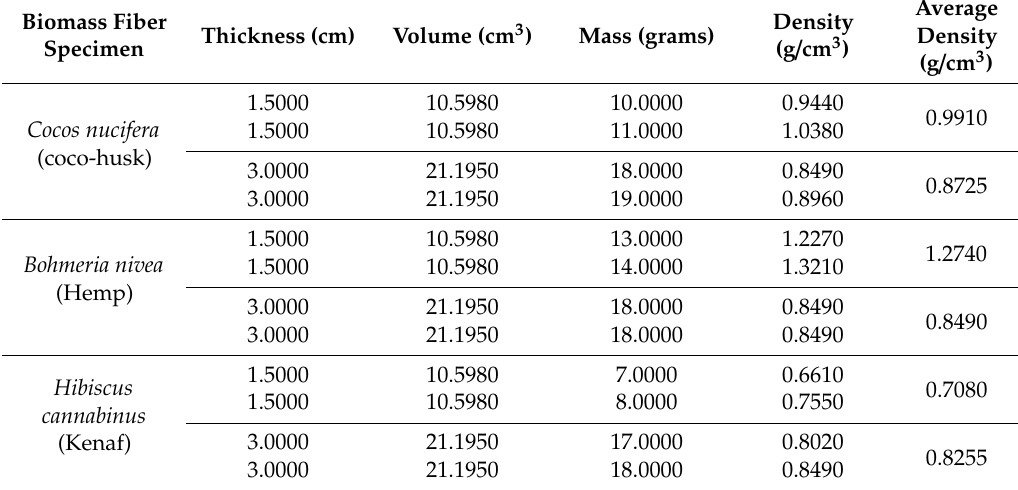
Table 2. The epoxy resin-reinforced biomass fiber-based